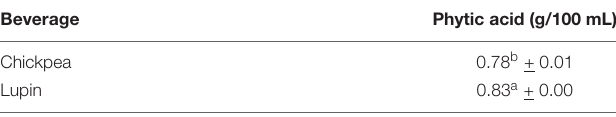
TABLE 2 | Phytic acid content of pulse-based beverages. Beverage Phytic acid (g/100 mL) Chickpea 0.78 b + 0.01 Lupin 0.83 a + 0.00